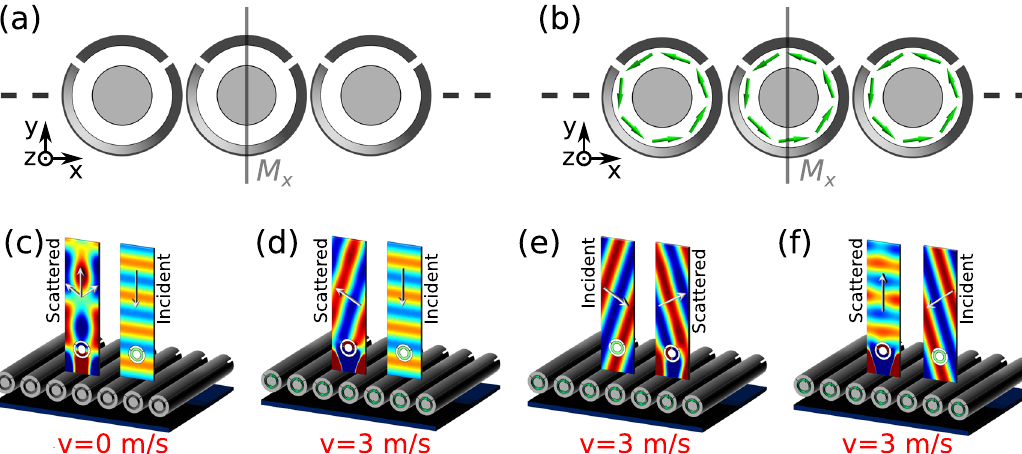
Fig. 5 Non-reciprocal meta-grating based on odd Willis inclusions. a , b An acoustic grating with geometrically symmetric unit cells. c With no bias fl ow, for a normally incident plane wave the re fl ected power is steered symmetrically towards left and right Floquet channels. d For a bias velocity of 3 m/s, a normally incident wave is totally re fl ected into the -1 diffraction order. e For excitation from the -1 diffraction direction, instead, all energy is routed towards the + 1 channel, con fi rming large non-reciprocity and isolation for free-space airborne sound waves. f For excitation from the + 1 order, unitary re fl ection is achieved towards normal